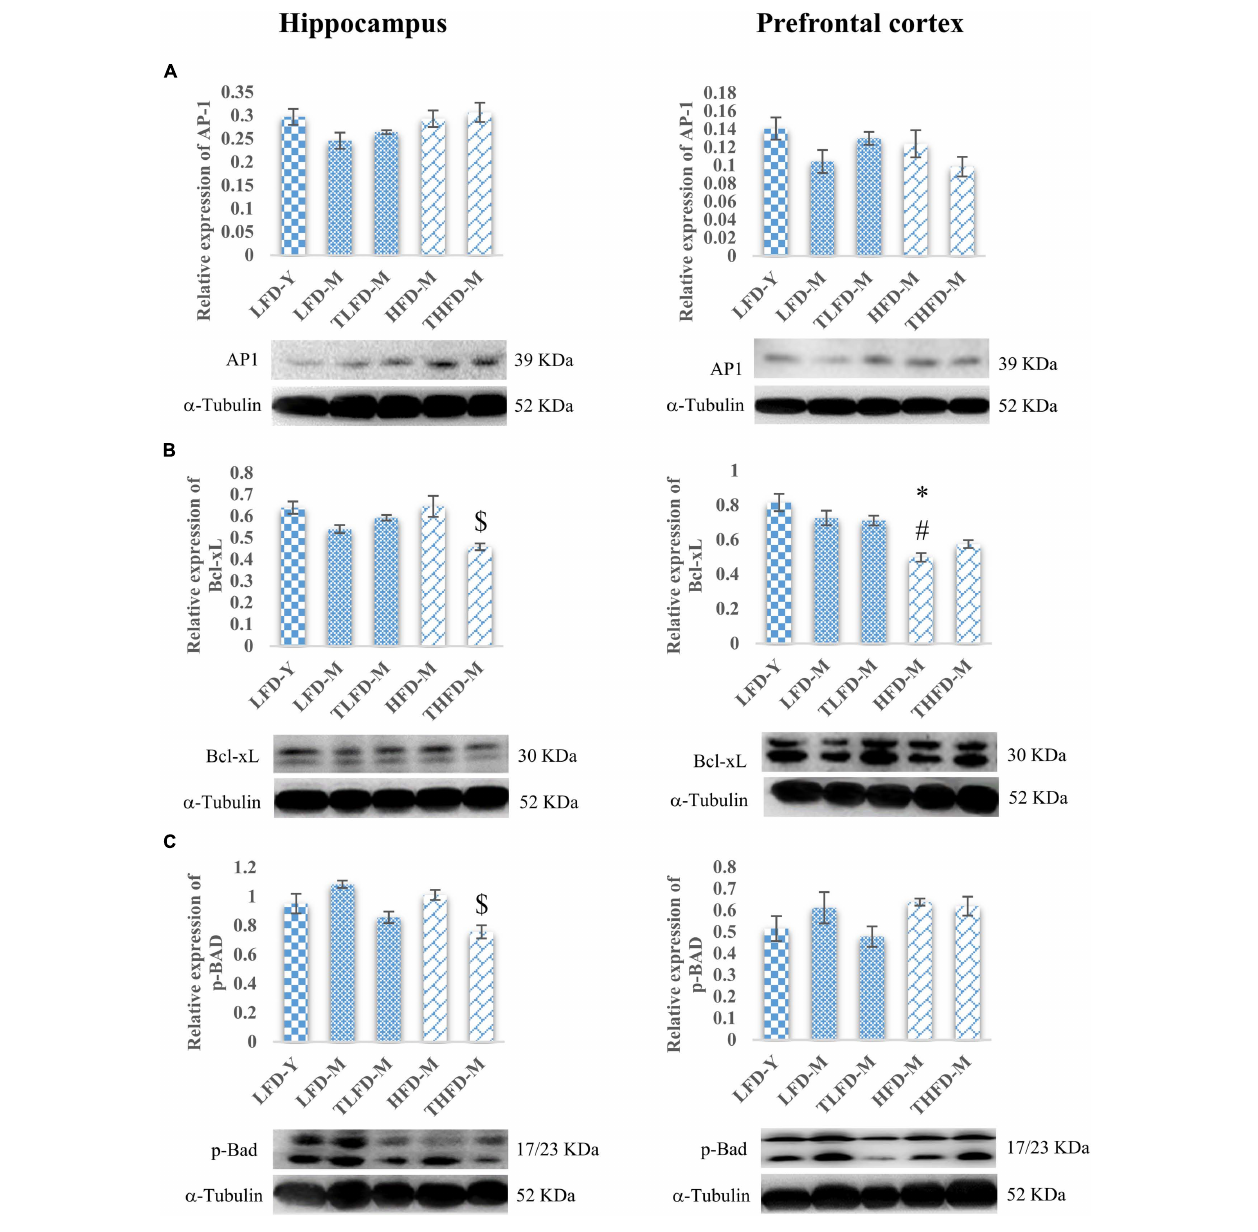
FIGURE 4 | Tinospora cordifolia stem powder (TCP) supplementation modulated the expression of target proteins associated with apoptosis in middle-aged acyclic female rats. Histogram representing analysis of fold change in expression of (A) AP1, (B) Bcl-xL, and (C) p-Bad in the hippocampus (left panel) and the prefrontal cortex (PFC) (right panel) regions of the brain. Values are presented as mean ± SEM. ∗ p ≤ 0.05 LFD-Y vs. HFD-M; # p ≤ 0.05 LFD-M vs. HFD-M; $ p ≤ 0.05 HFD-M vs.